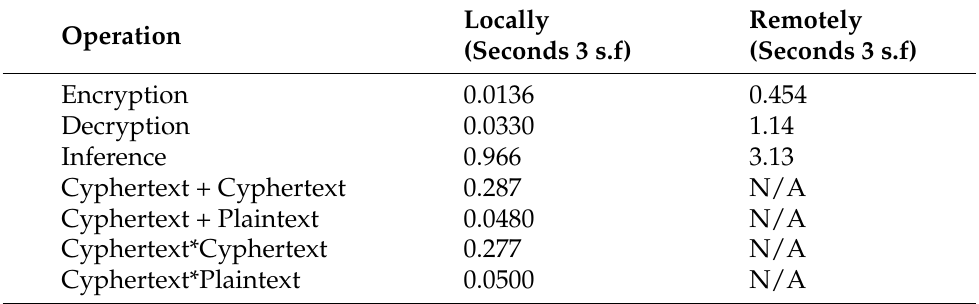
Table 2. Time performance for different operations, both locally and remotely. It should be noted that N/A (not applicable) is used to identify operations which are not implemented atomically as remote API operations as they would not make sense since they are too atomic to warrant the transmission overhead alone. These operations of course still exist on the server side but embedded into much more complex operations such as part of inference in our neural network depicted in Figure 4.